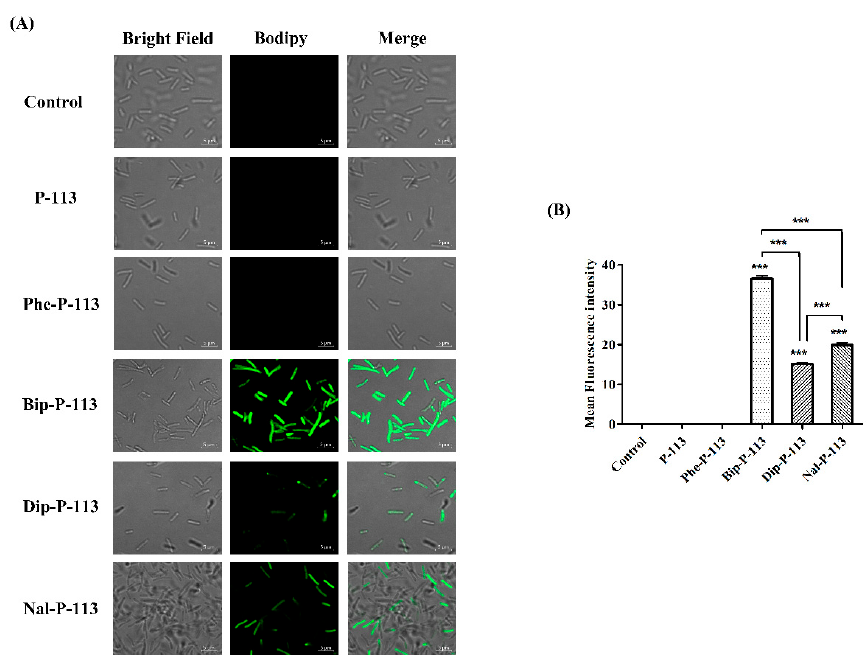
Figure 4. P-113 and its derivatives increase the uptake of BODIPY-labeled vancomycin in E. coli . ( A ) Fluorescence images of 10 7 CFU / mL E. coli ATCC 25922 treated with 0.5 × MIC of P-113, Phe-P-113, Bip-P-113, Dip-P-113, and Nal-P-113 at 37 ◦ C for 30 min, then treated with BODIPY-labeled vancomycin for 30 min (scale bar represents 5 µ m). ( B ) Mean fluorescence intensity of P-113, Phe-P-113, Bip-P-113, Dip-P-113, and Nal-P-113 treated in E. coli ATCC 25922. Samples treated with BODIPY-labeled vancomycin only served as a control. Results are presented as means ± SEM, *** p < 0.001 compared with control. The experiments were performed in triplicate.